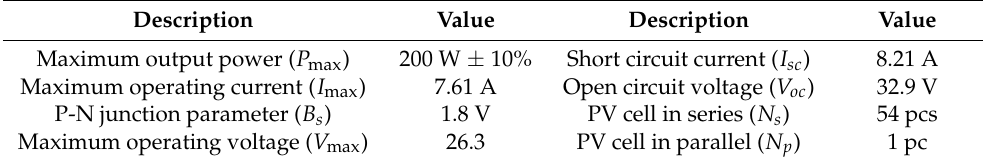
Table 3. Relationship between the output voltage and current under partial influences.